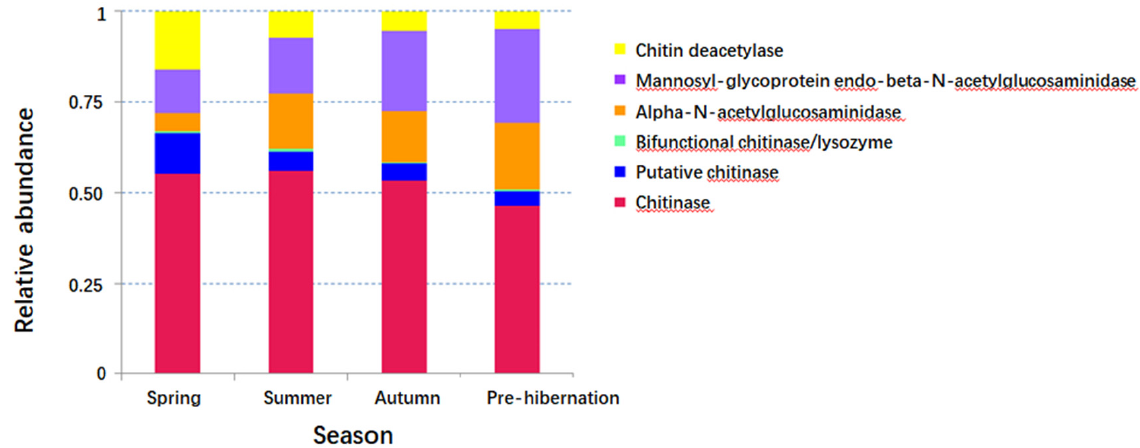
Figure 5. Abundance of Tax4Fun-predicted reads annotated to genes for chitin-degrading enzyme. The potential function of the intestinal microbiota was compared between females and males in autumn. In female frogs, nucleotide metabolism was significantly higher in autumn ( t -test, p = 0.038). The total abundance of chitinase and antibiotic genes in females was higher than that in males (Figure S6a,b). Chitin-degrading enzyme (putative chitinase and bifunction chitinase/lysozyme) and antibiotic genes tetracycline biosynthesis and clavulanic acid biosynthesis) were significant different between females and males in au- tumn (Wilcoxon rank-sum test: putative chitinase, p = 0.036; bifunction chitinase/lysozyme, p = 0.016; tetracycline biosynthesis, p = 0.040; and clavulanic acid biosynthesis, p = 0.041). In addition, the vancomycin resistance gene was also a significant difference between females and males in autumn (Wilcoxon rank-sum test, p =